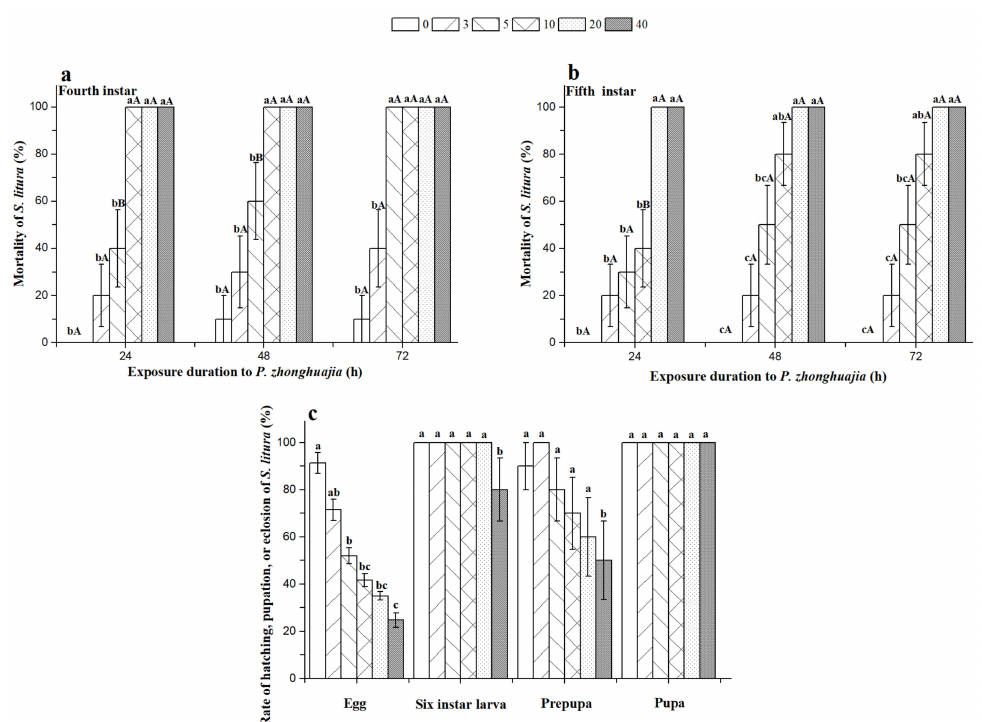
Figure 3. Mortality of fourth to fifth instar larvae. ( a , b ) Rate of mortality, hatching, pupation, and eclosion ( c ) of Spodoptera litura when exposed to different mite densities (0, 3, 5, 10, 20, or 40 mites). Different lower-case letters on top of bars indicate significant differences in mortality of different densities of Pyemotes zhonghuajia to fourth and fifth S. litura instar larvae in each exposure duration and in the hatch rate of eggs, pupation of sixth instar larvae, eclosion rate of prepupae, and pupae of S. litura . Different capital letters on top of bars indicate significant differences in mortality of fourth or fifth S. litura instar larvae at different hours, respectively (Tukey’s honest significant difference (HSD) test, p < 0.05).